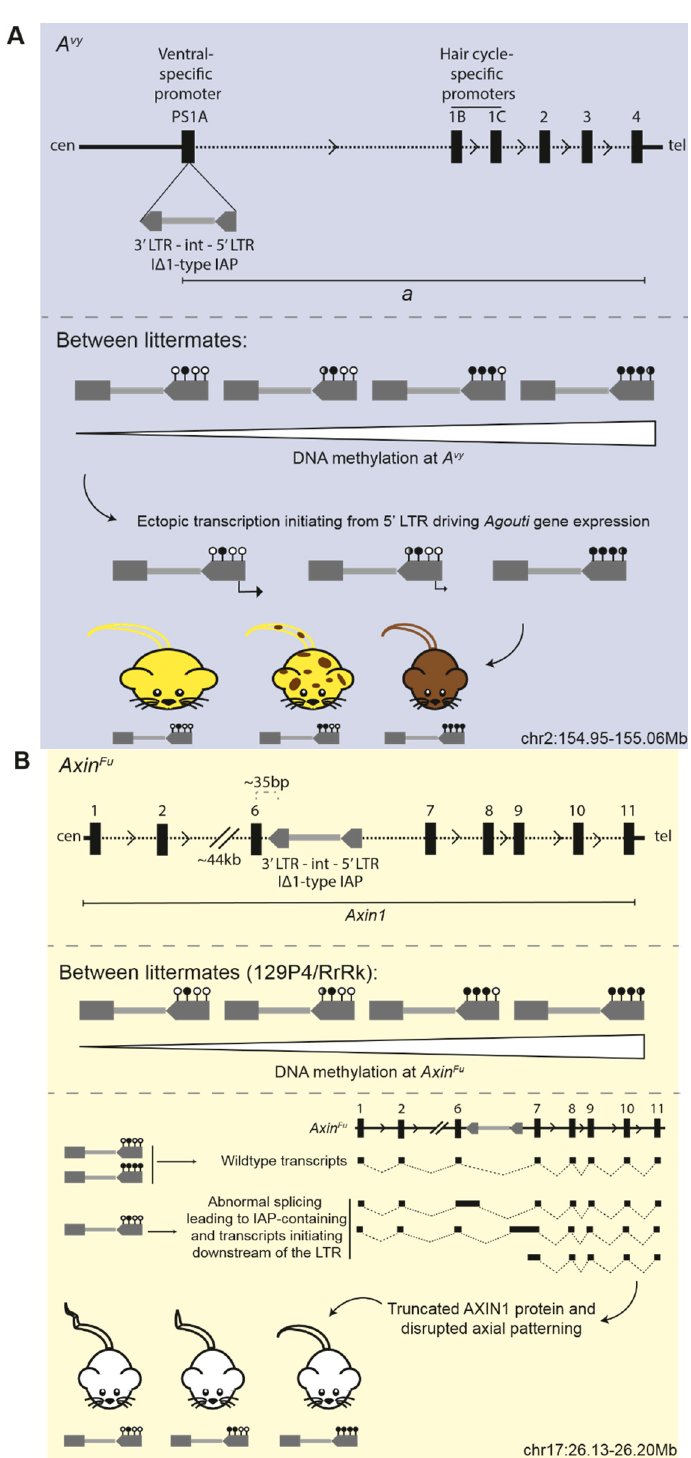
Figure 3. Schematics depicting the insertion sites of the metastable epialleles ( A ) A vy and ( B ) Axin Fu . Upper panel shows the intracisternal A-type particle (IAP) insertion relative to the affected gene; lower panel shows the functional consequence of the variably methylated IAP element. Coordinates are mm10. Sticks with closed circles represent methylated CpGs in the LTR of the ERV; sticks with open circles represent unmethylated CpGs. Black dotted lines depict introns; thick black lines depict intergenic regions.